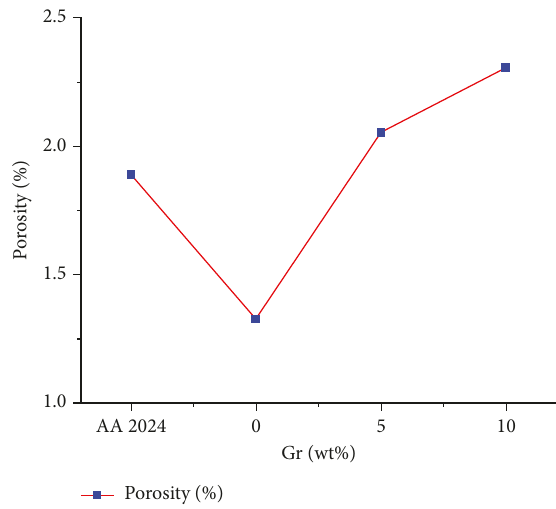
Figure 3: Attained porosity results for fabricated